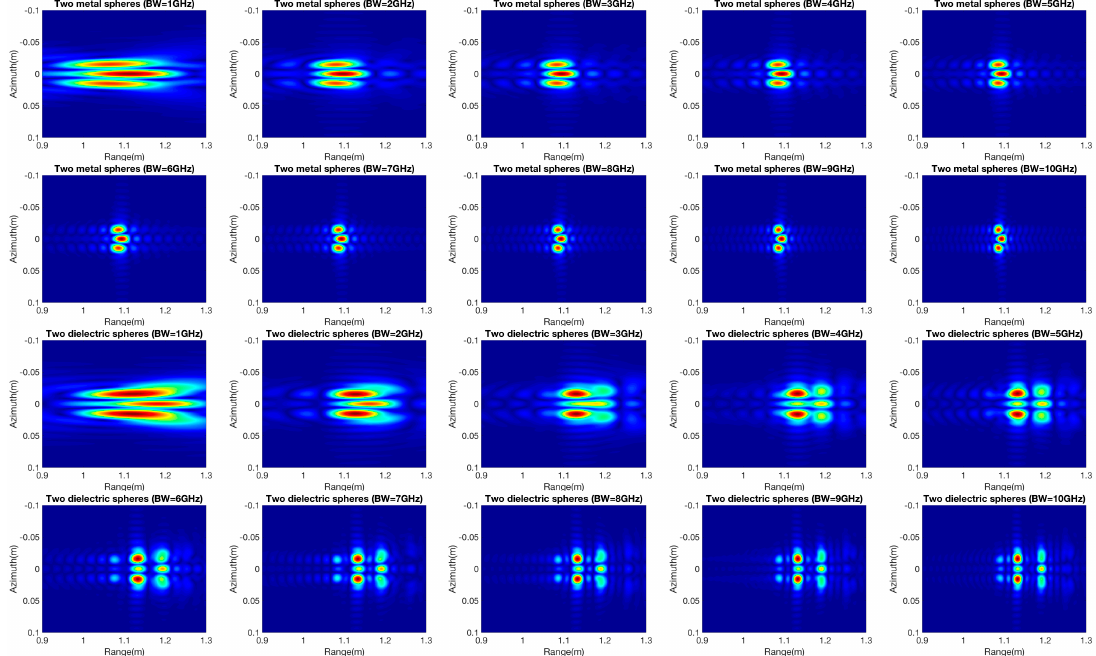
Figure 12. Image of two metal spheres ( top two rows ) and two dielectric spheres ( bottom two rows ) with SAR bandwidth varying from 1 GHz to 10 GHz.